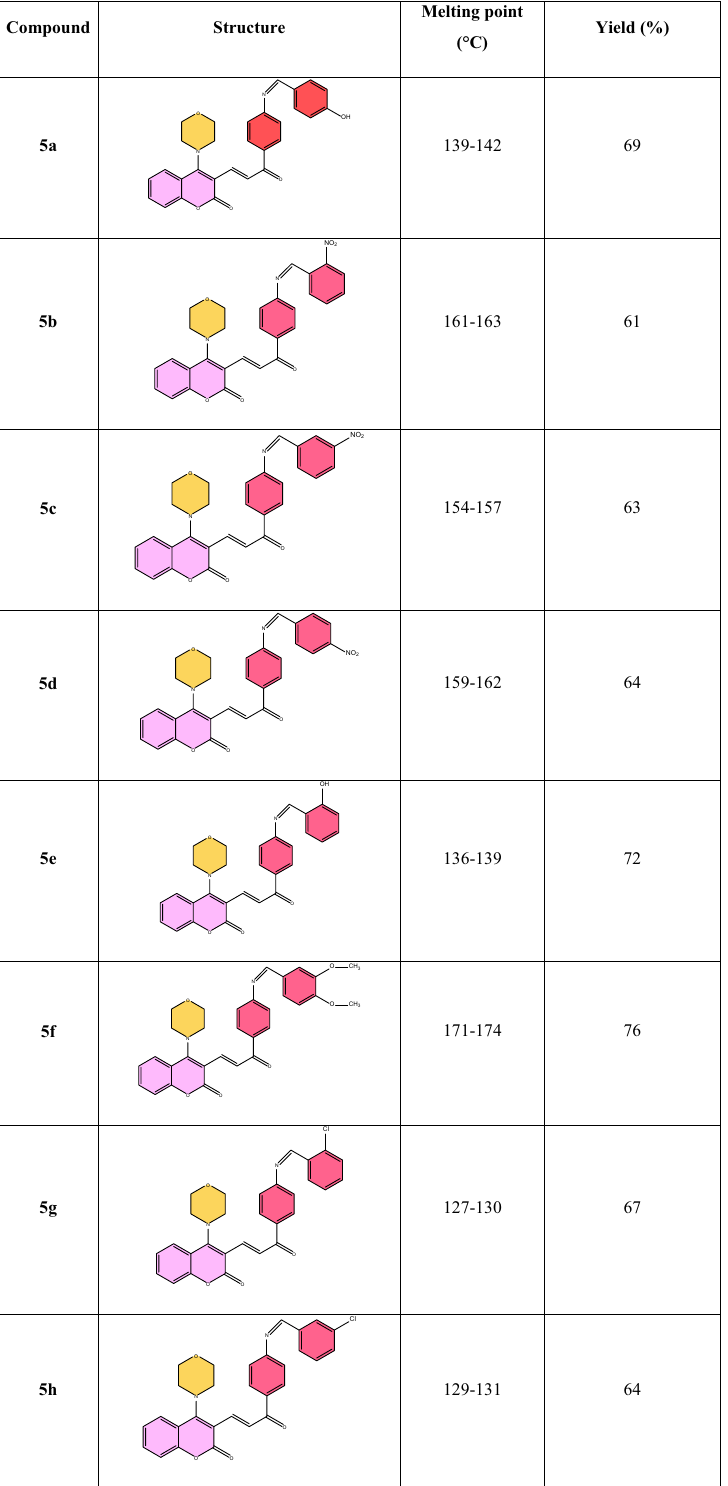
Melting point Yield (°C)